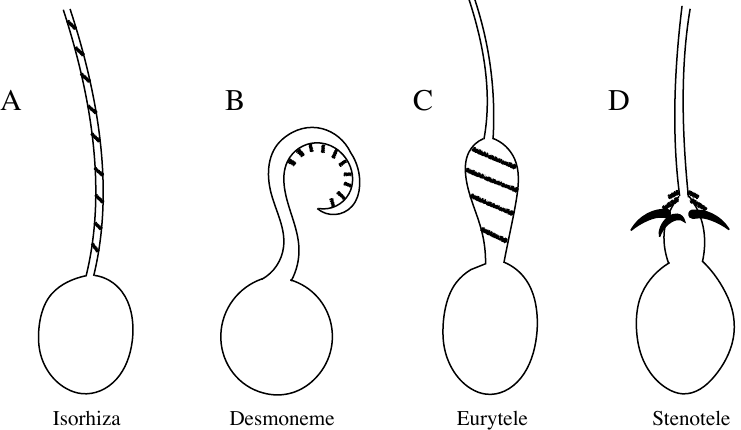
Figure 1. Schematic drawings of several different nematocysts after firing (lines indicate spines): ( A ) Holotrichous isorhiza (with uniformly distributed spines) and ( B ) Desmoneme (ensnaring capsules). The eurytele nematocyst ( C ) has a nonuniform tubule with spines. Stenotele nematocysts ( D ) contain large stylets, denoted by thick black pointed shapes, to penetrate prey.